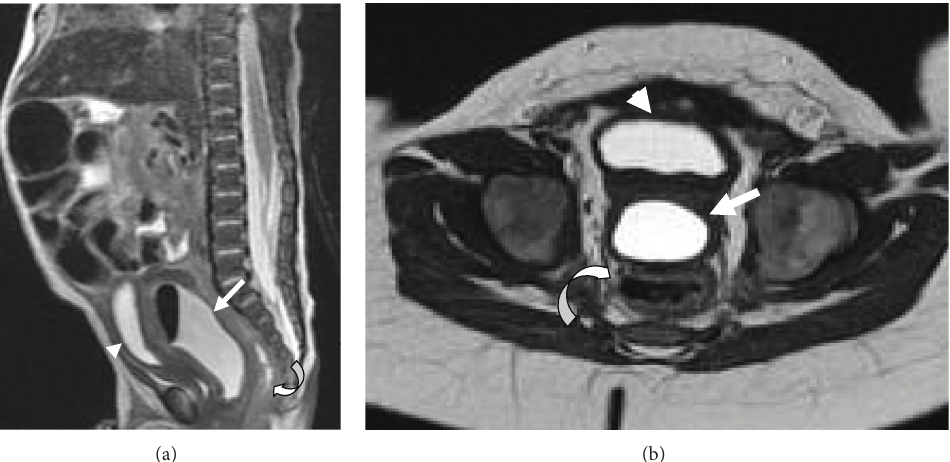
Figure 3: Sagittal (a) and axial (b) T2 turbo spin echo (TSE) MR image show a T2 hyperintense cystic structure representing the prostatic utricle cyst (white arrow), encapsulated by a rim of T2 isointense prostatic tissue, located between the rectum (curved arrow) and urinary bladder (arrowhead).